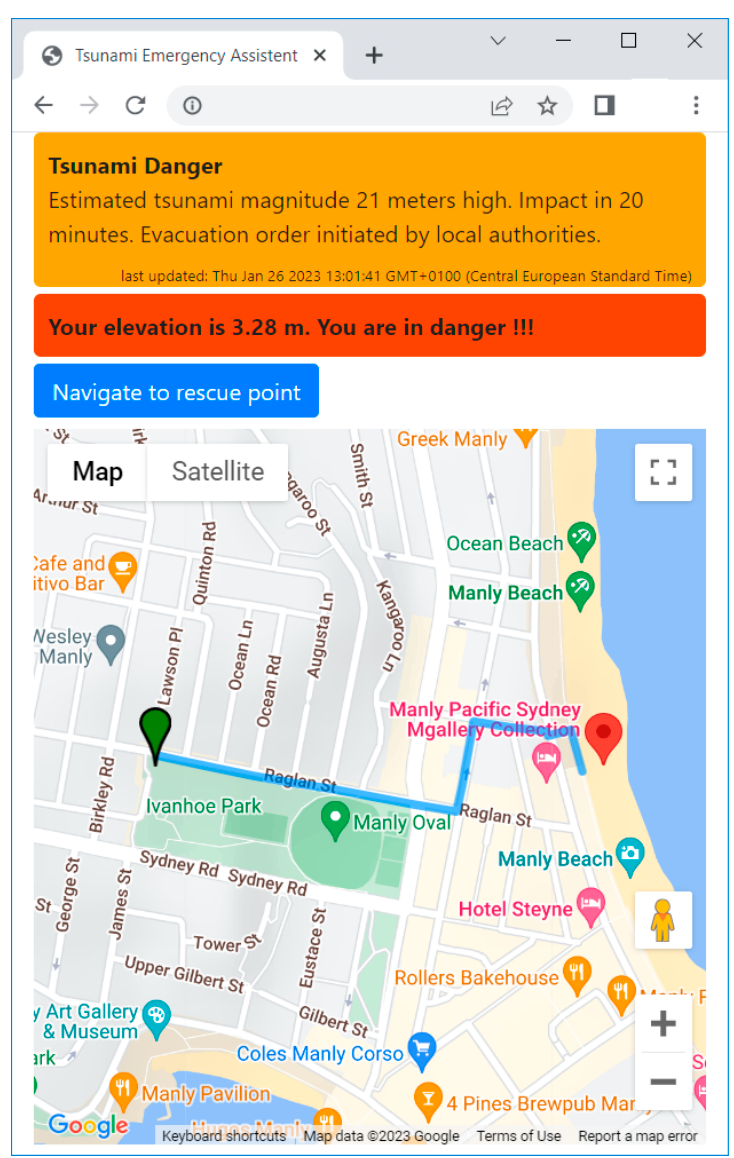
Figure 4. The figure shows the screen of the tsunami emergency assistant. The upper orange part displays the notification received from the tsunami emergency dashboard. The grey bar contains information about the user’s status. The map can be used to navigate to the closest available safe location. The large red location icon on the map shows the current user position. The green location icon is for a safe location. The shortest path from the current user position to the safe location is marked with the blue line.